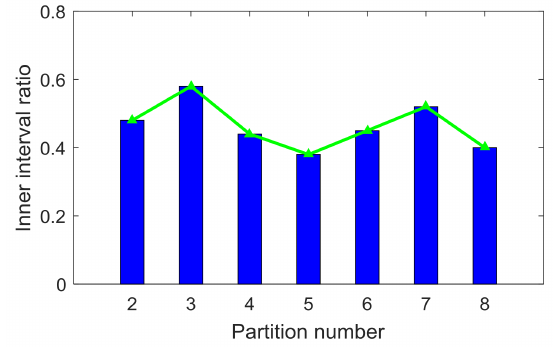
Figure 11. The inner interval ratio of the energy supply partition under different integrated energy supply centres’